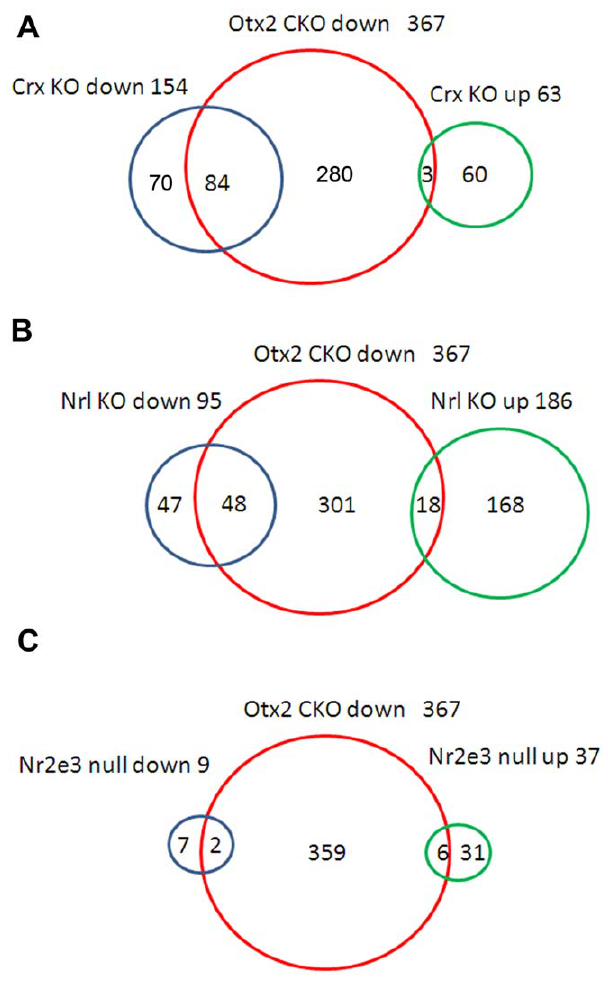
Figure 4. Comparison gene expression profiles with the Otx2 - CKO retina. (A-C) Microarray analysis datasets from Crx (A), Nrl (B), Nr2e3 (C) KO retinas were compared with that from the Otx2 CKO retina at P12. We identified 367 down-regulated probes in the Otx2 CKO retina (signal log ratio #2 2.0, signal intensity $ 74). We used datasets from previous microarray analysis of the Crx , Nrl and Nr2e3 -null retinas at P21 with the following results: 154 probes down-regulated in the Crx KO retina (signal log ratio #2 2.0, signal intensity $ 352), 63 probes up- regulated in the Crx KO retina (signal log ratio $ + 2.0, signal intensity $ 345), 95 probes down-regulated in the Nrl KO retina (signal log ratio